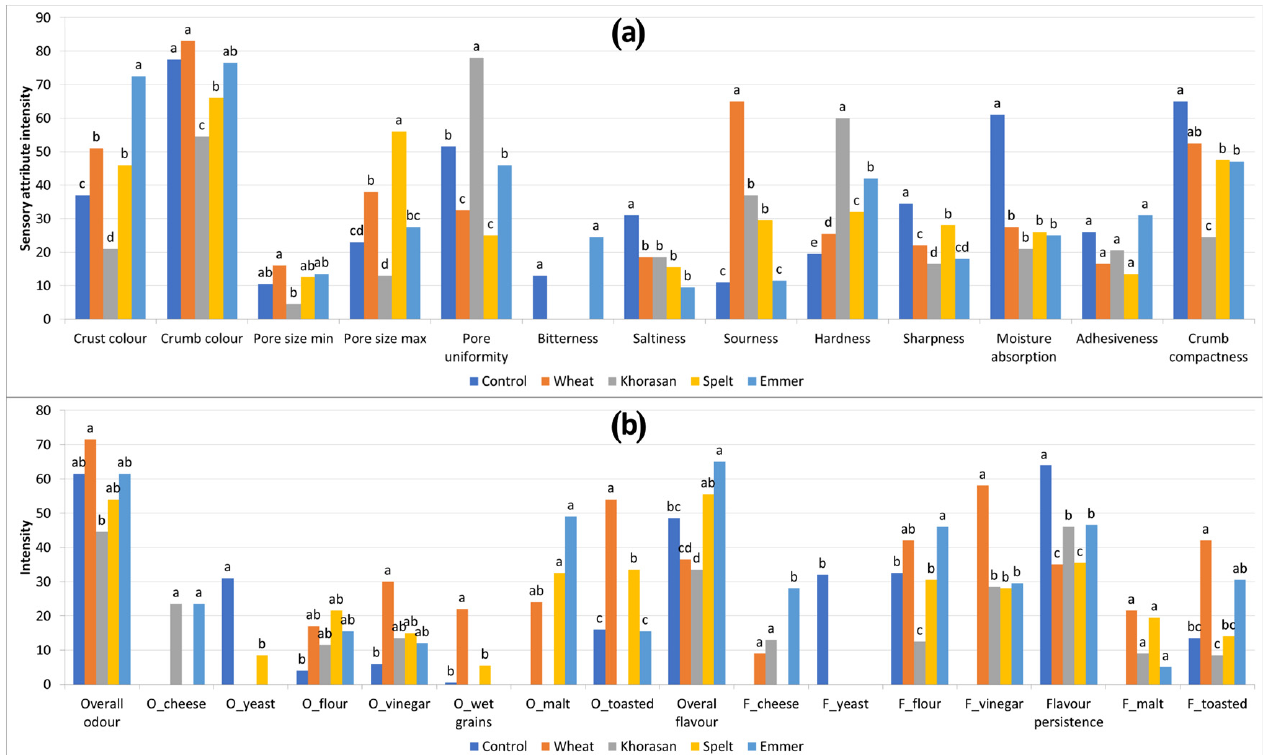
Figure 4. Average intensities of the appearance and texture ( a ) and odour and flavour ( b ) of sour- dough bread samples (“O” in the name of sensory descriptor refers to the “odour” attribute, while “F” refers to the “flavour” attribute) (different letters above the bars indicate statistical differences ( p < 0.05) among the samples according to Tukey’s minimum square difference